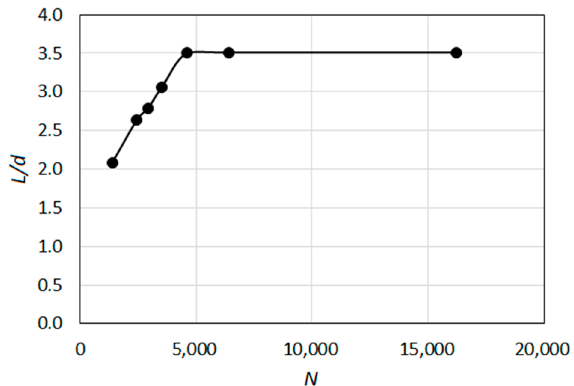
Figure 4. Variation of predicted length of the potential core with grid resolution (isothermal test case).